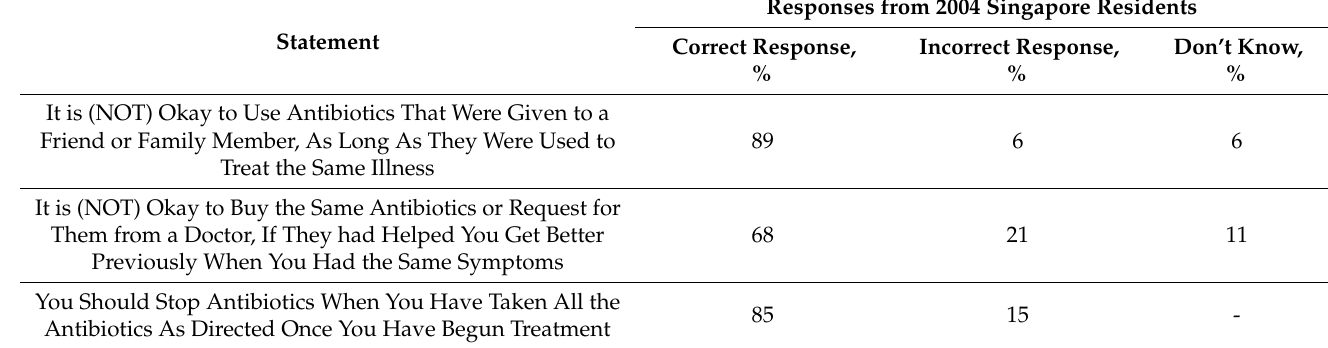
Table 2. Proportion of correct responses provided by 2004 Singapore residents on statements related to antibiotic